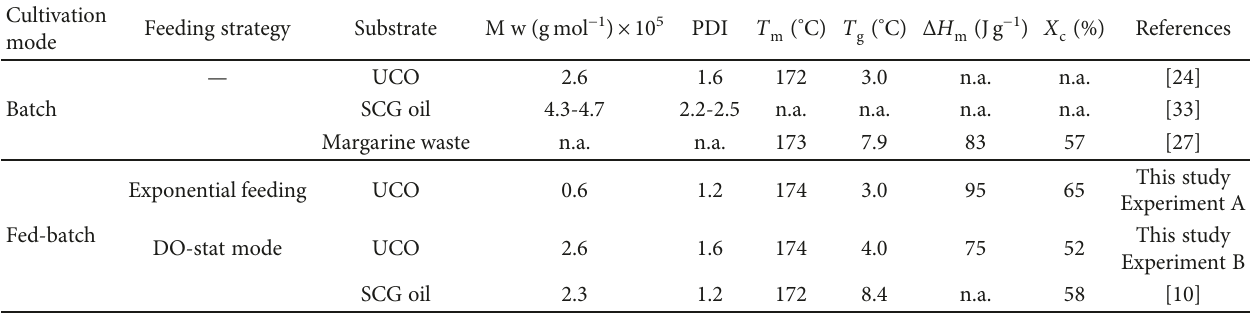
Table 2: Physical-chemical and thermal characterization of P(3HB) produced by C. necator from UCO and comparison to P(3HB) produced from other oil-containing